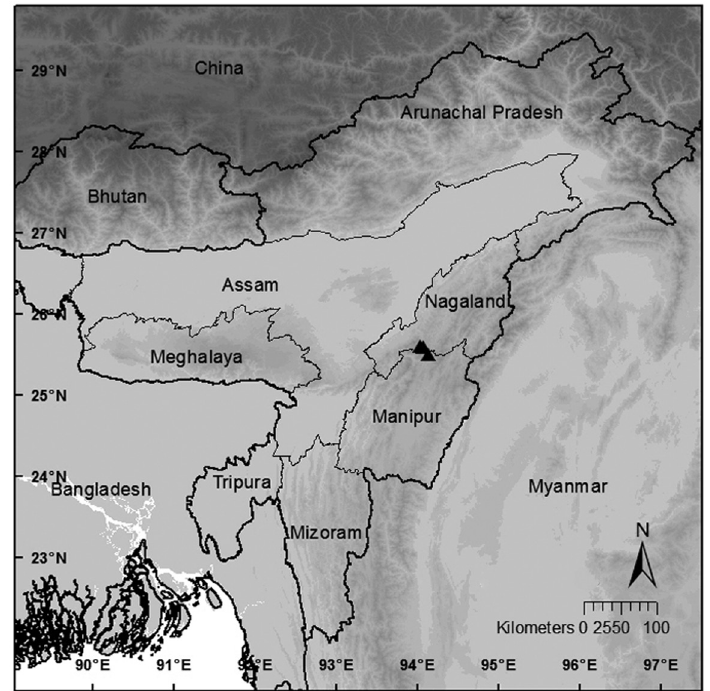
Fig. 8. Map showing the location of B. adscendens